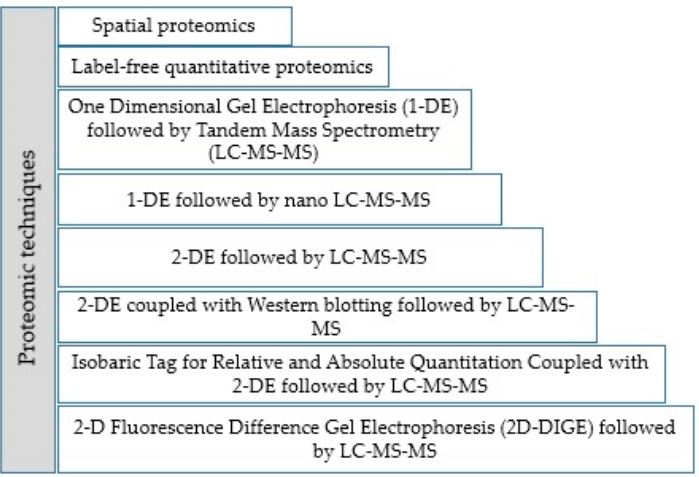
Figure 1. Proteomic techniques mainly used for the identification of T. gondii proteome. Table 1. The biological functions of proteins expressed in life cycle-specific stages of Toxoplasma parasites employed as vaccine